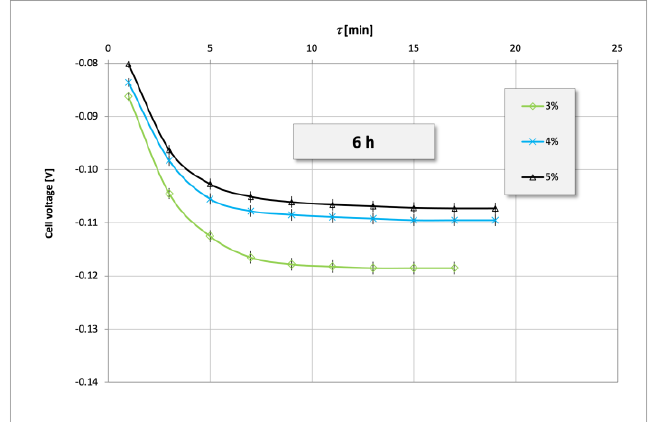
Figure 4. Cu-Ag cathode oxidized for 6 h — the electroless potential of cathode.